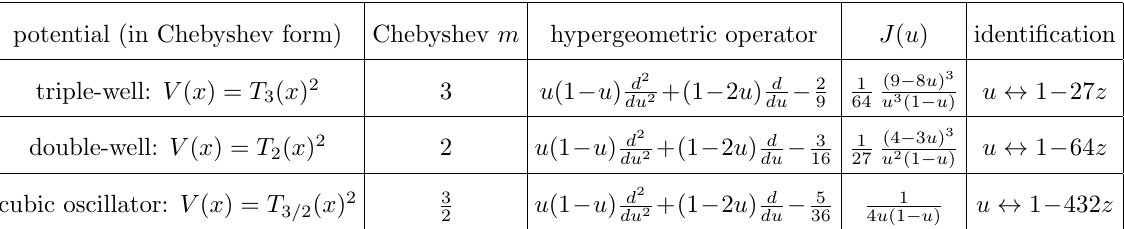
Table 4 . Arithmetic Chebyshev potentials, with their associated hypergeometric di(cid:11)erential op- erator for the periods, and the corresponding modular J ( u ) derived from the elliptic curve (see appendix A). The last column shows the conversion needed for the comparison with table